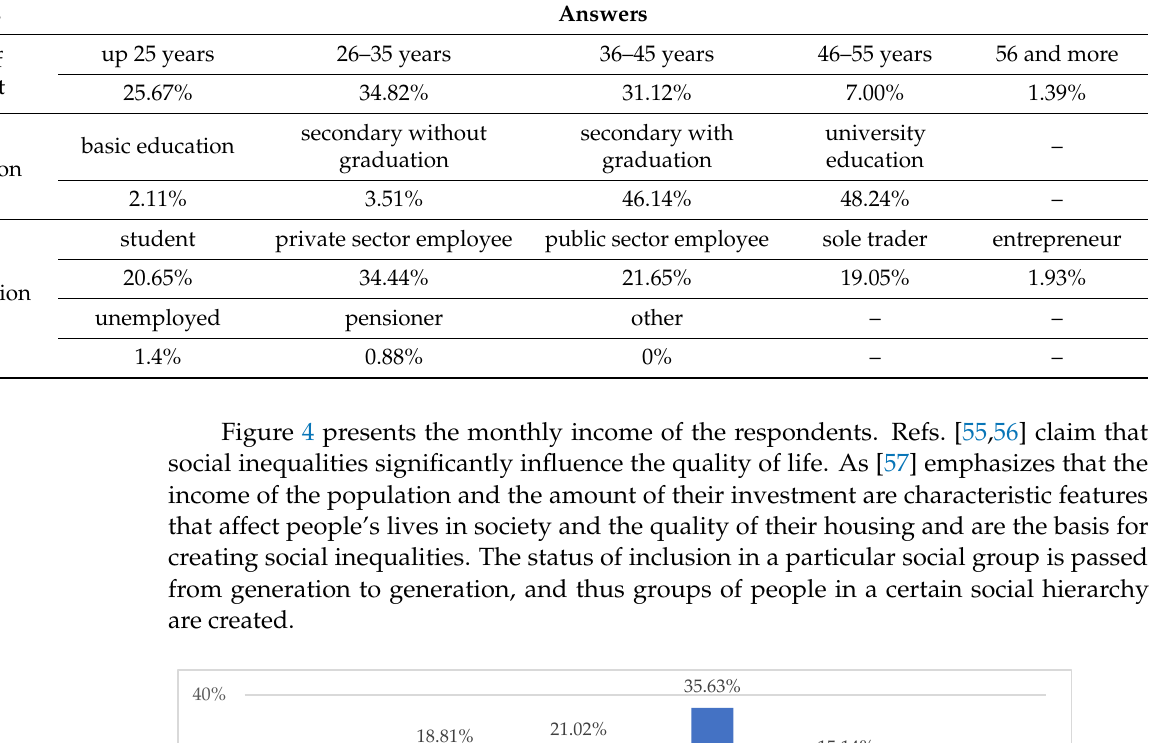
Table 4. Answers of respondents on the questions X3–X5.